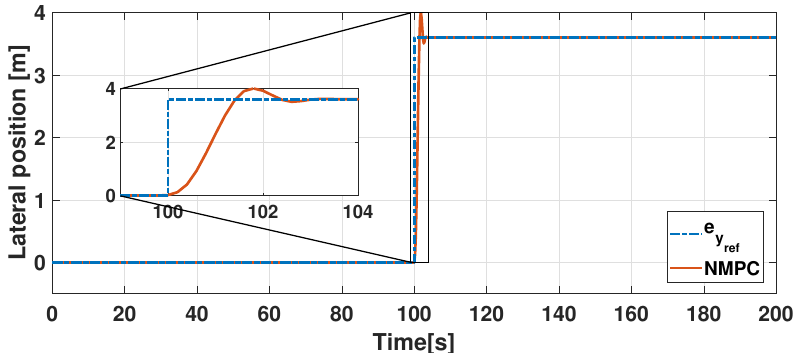
Figure 8. Single lane changing scenario . Performance of the proposed solution and comparison analysis w.r.t. IDM solution. Time-history of the Ego vehicle lateral position e y ( t ) .